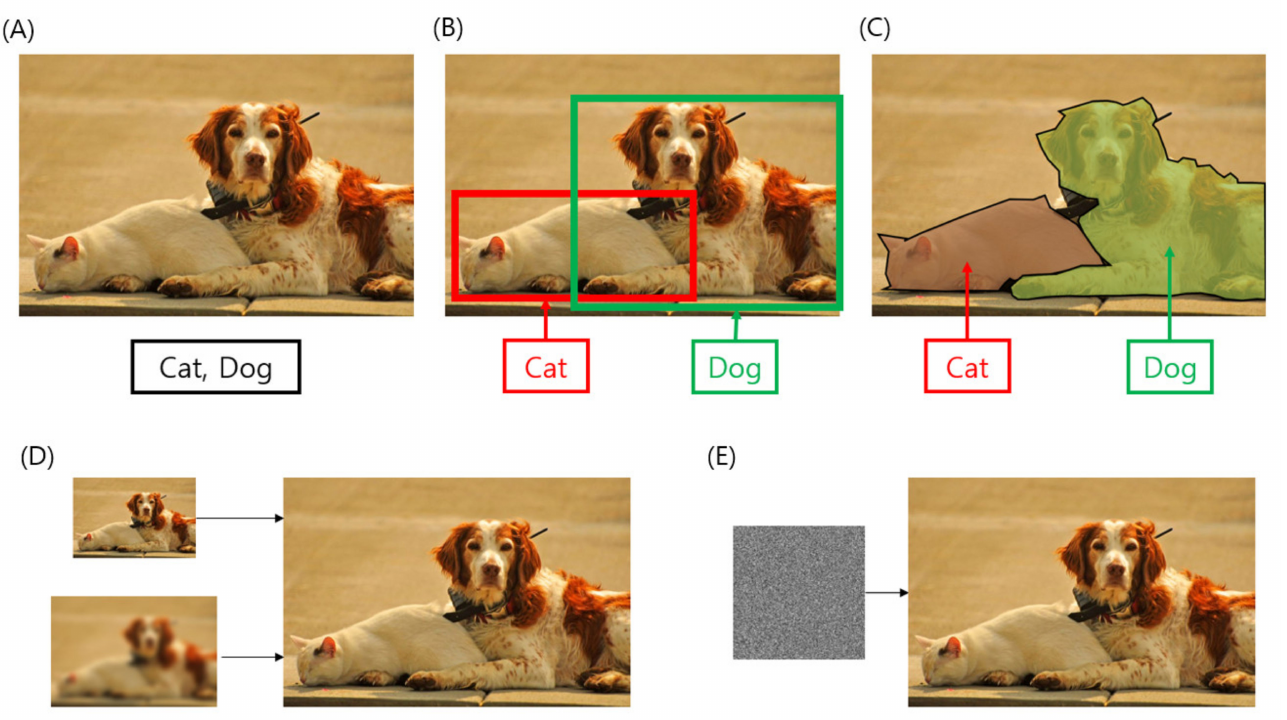
Figure 3. A list of computer vision algorithms. ( A ) Image classification. ( B ) Object Detection. ( C ) Se- mantic segmentation. ( D ) Image reconstruction. The top represents a super-resolution algorithm, while the bottom represents an image deblurring. ( E ) Image generation from random noise. The sample image is brought from MS COCO dataset provided under a Creative Commons Attribution 4.0 License